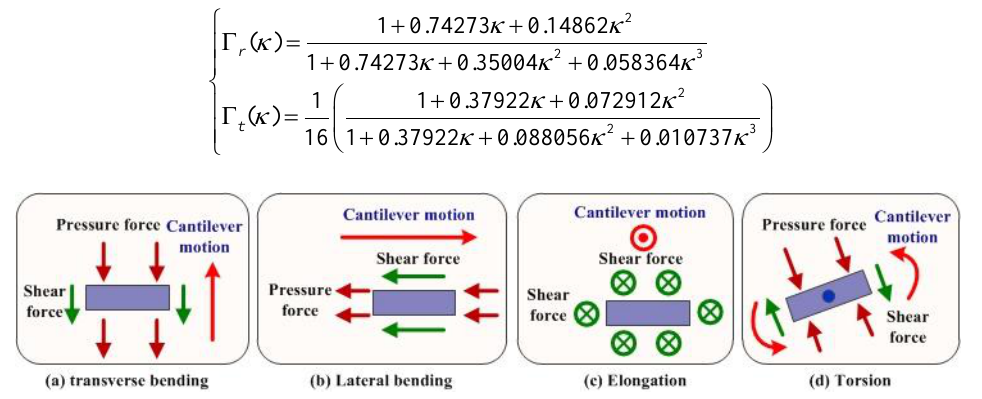
Figure 18. Schematic of the hydrodynamic force acting on the microcantilever cross section in the cases of four modes. ( a ) Transverse (out-of-plane) bending mode; ( b ) Lateral (in-plane) bending mode; ( c ) Elongation (in-plane) mode; ( d ) Torsional (out-of-plane)